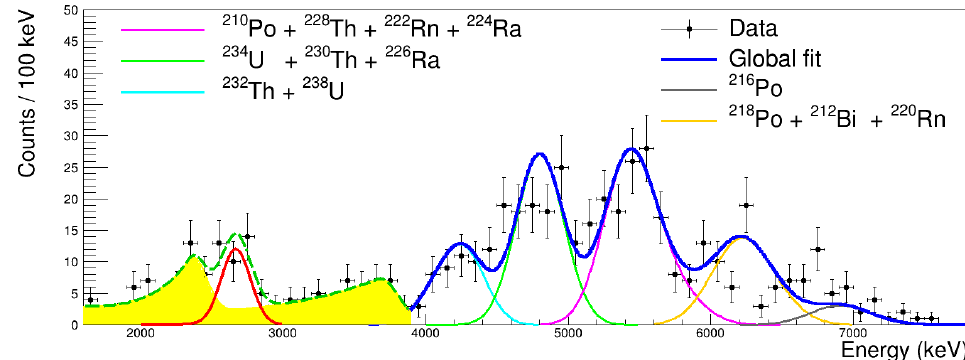
Figure 5. Energy spectrum of the “pure” alpha selected by pulse shape analysis events in the energy range from 1.5 to 8.0 MeV from the data collected in the low-background measurements with the 7 g CHC scintillating crystal over 2848 h [7]. The energy scale is calibrated taking into account quenching factor values for internal alpha particles. Above 4 MeV, the global fit of the data by the background model built based on alpha decays of radionuclides from 232 Th and 238 U decay chains is shown by blue solid line (individual components of the background model are also shown). Below 4 MeV, the fit of the data with model built from 174 Hf alpha decay (red line) and 147 Sm alpha decay plus degraded alphas and an exponential function (to describe residual of beta/gamma events) is shown (green dashed line). The yellow area represents the background model with respect to the signal from 174 Hf alpha decay.